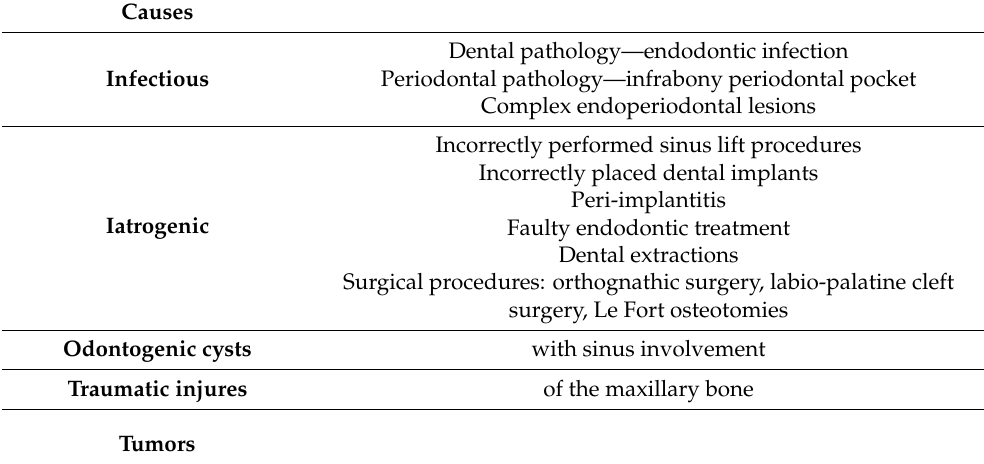
Table 1. Causes of perforation of the Schneiderian membrane that may cause odontogenic